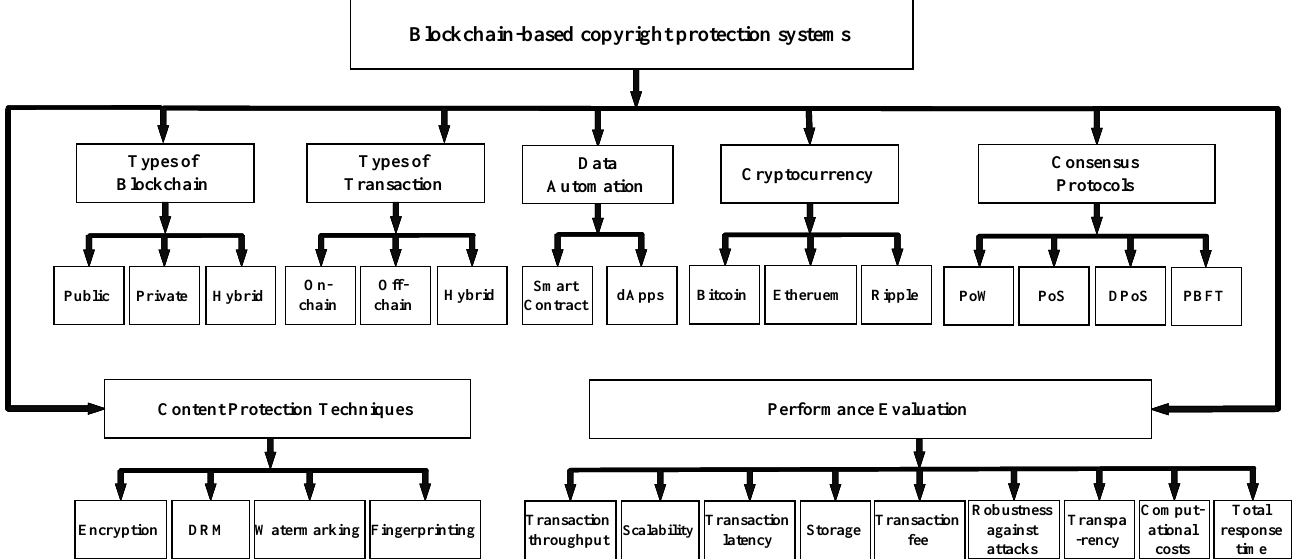
Figure 1. Taxonomy of Blockchain-based Copyright Protection